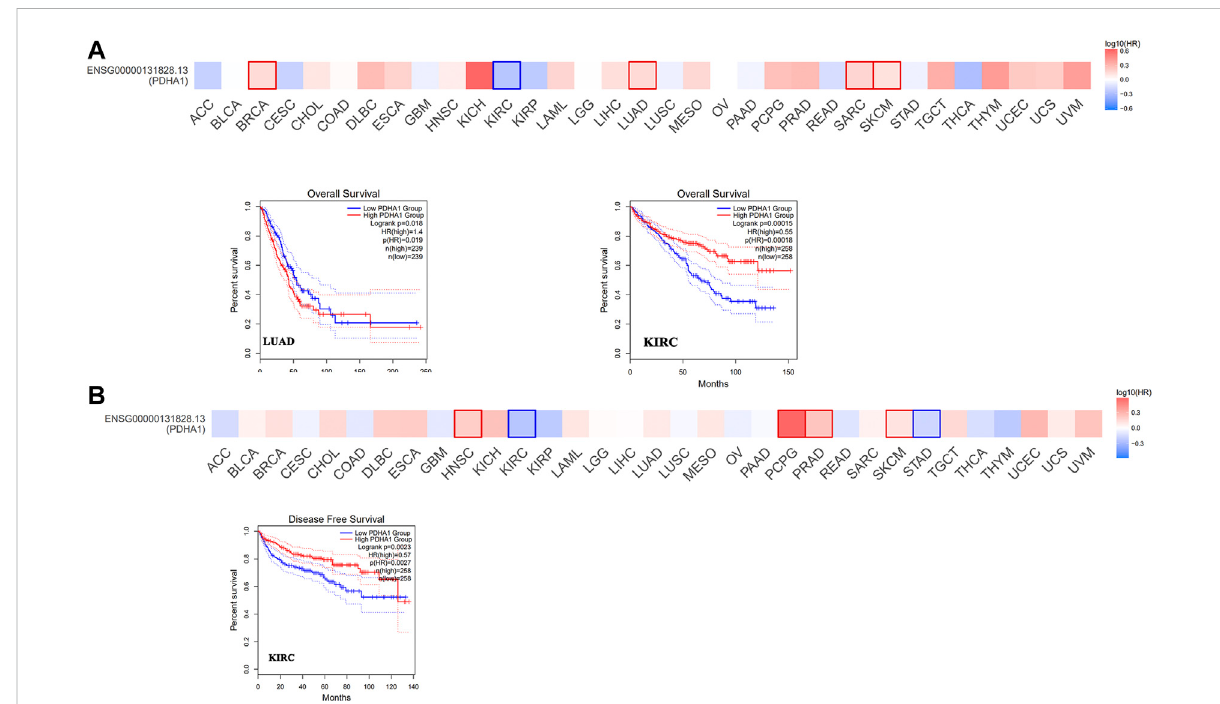
FIGURE 2 Survival analysis of PDHA1 expression in pan-cancer. (A,B) GEPIA2 indicated the roles of PDHA1 expression in patients ’ prognosis, including OS (A) and DFS (B) . High cutoff (50%) and low cutoff (50%) values were used as the expression thresholds for splitting the high-expression and